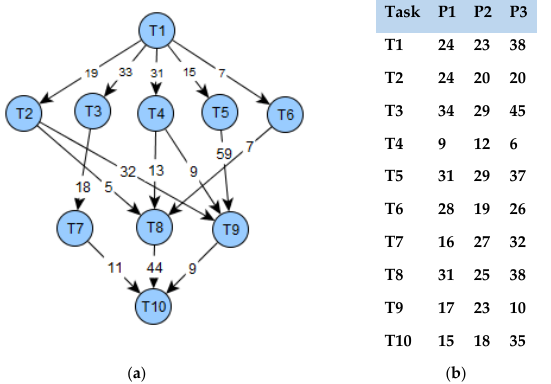
Figure 3. ( a ) Sample DAG with the transfer cost of 10 tasks. ( b ) Computation cost of 10 tasks and 3 processors.